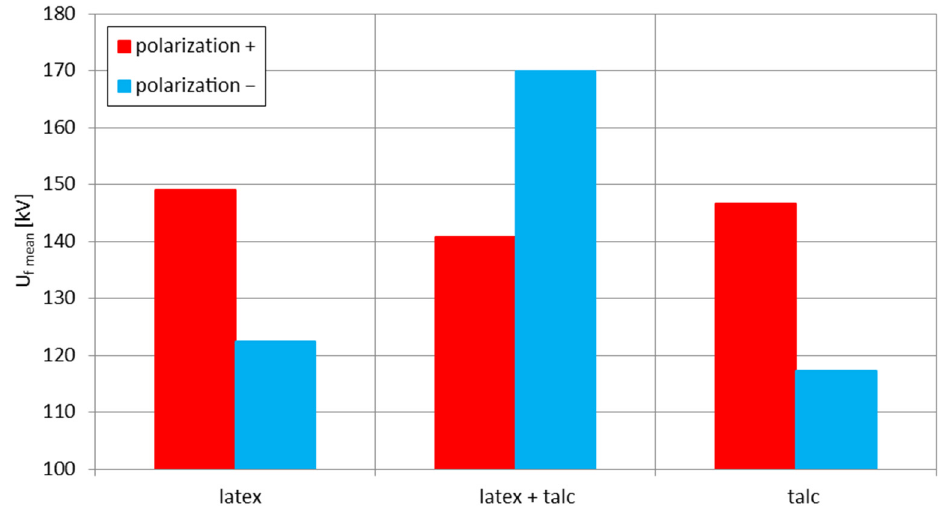
Figure 6. Recorded mean flashover voltages for two polarizations and three considered cases of latex/talc configuration.